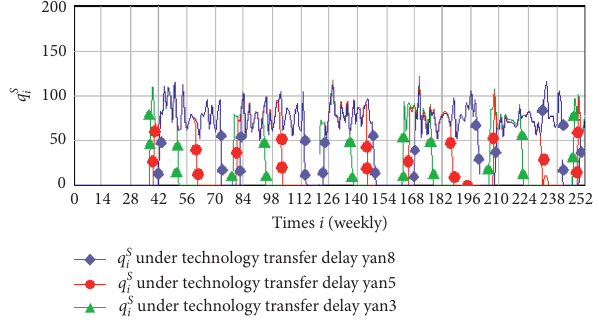
Figure 4: The impact of core production technology transfer delay on the emergency